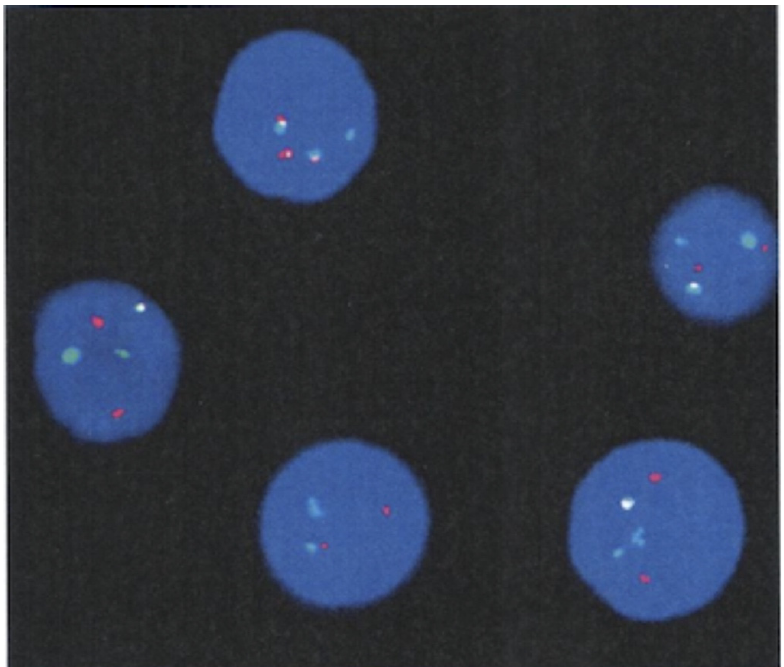
Figure 2. The dual ‐ color and dual ‐ fusion FISH of the BCR::ABL1 fusion gene was 1F2R2G (82%), 2F1R1G (10%) and 2R2G (8%) (the red signal (R) indicates the ABL1 probe; the green signal (G) indicates the BCR probe; F indicates the fusion signal; normal nucleus, 2R2G; nucleus with a classical t (9,22) translocation, 2F1R1G; cut ‐ off value, 1F (11%), 2F (2%)).